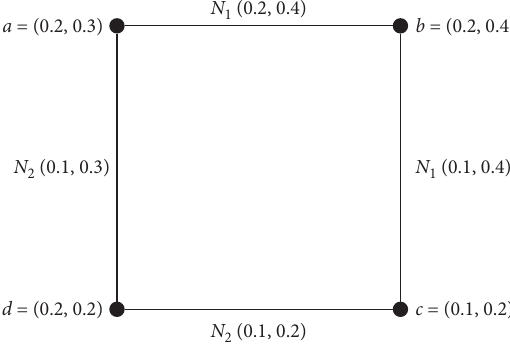
Figure 1: Vague graph structure ξ . Table 1: Some basic